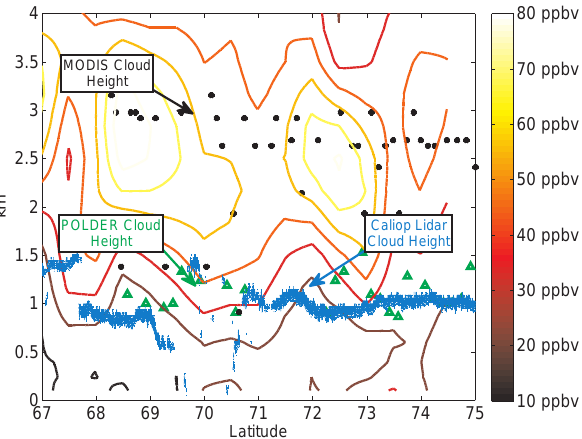
Fig. 3. Illustration of the vertical co-location method used for satellite cloud data and chemi- cal tracer transport model output. The colors represent values of the CO pollution tracer for a vertical slice along the 30 ◦ East meridian shown in Figure 2. The △ represent the POLDER retrieved cloud top pressure. After co-locating fields of cloud properties both horizontally and temporally, the cloud top pressure is matched to the output of the FLEXPART model that cor- responds to the vertical location of the cloud.